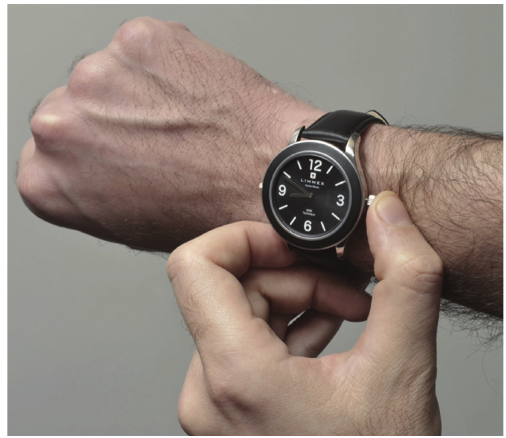
Figure 1: Limmex emergency wrist watch: there are two crowns, the one on the left for adjusting time and the one on the right (the larger one) for triggering the emergency call.